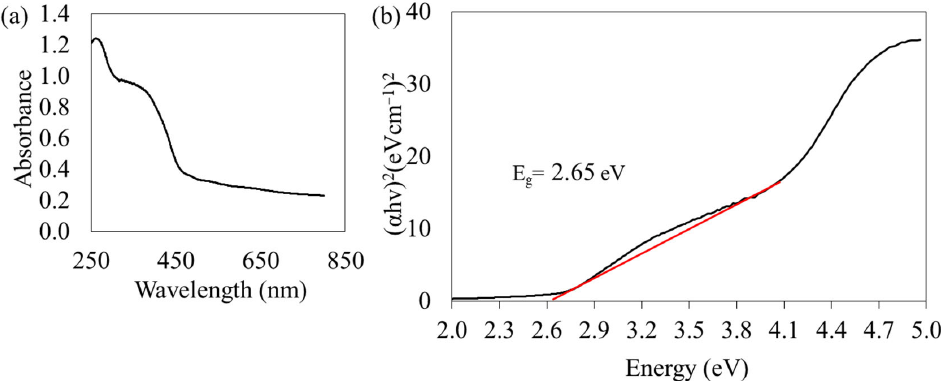
Figure 5. ( a ) UV-visible diffusion reflectance of the spectrum and ( b ) plots of ( α hv) 2 vs. energy of HPOM.